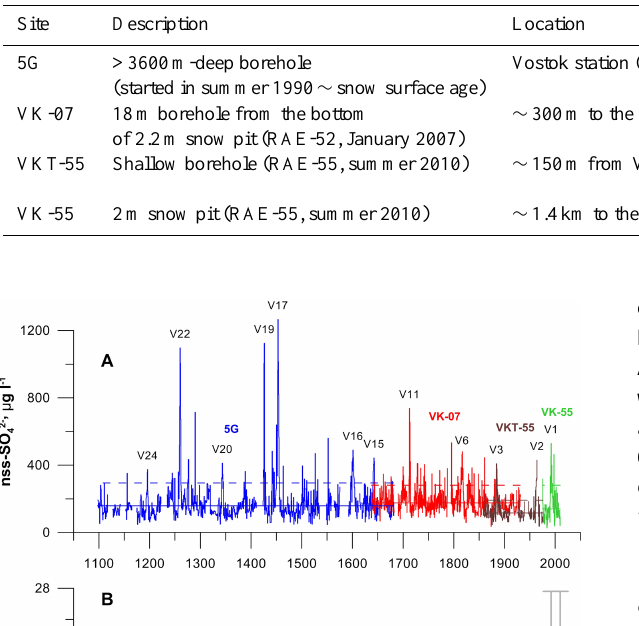
Table 1. Description of snow/firn cores used in this study (for locations see also Fig. 1).